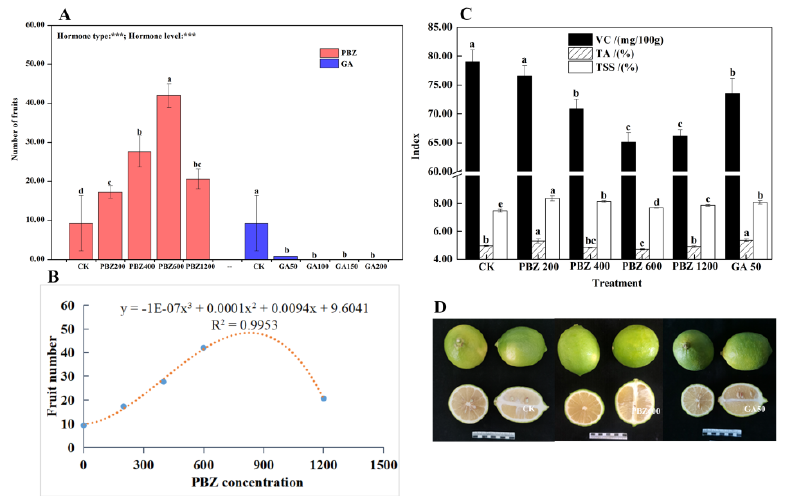
Figure 4. Effects of hormone regulation on fruit load and quality of lemons. ( A ) Effects of hormone regulation on number of fruits; ( B ) PBZ concentration–fruit number curves fit to pooled data calculated by an equation; ( C ) effects of hormone regulation on TSS, TA, and VC contents; ( D ) fruit morphologies under different treatments. Different letters (a, b, c and d) denote significant differences based on a p value < 0.05. *** denotes extremely significant difference ( p < 0.001). Table 1. Effects of hormone regulation on quality of lemon fruit. Different letters (a, b, c and d) denote significant differences based on a p value < 0.05.